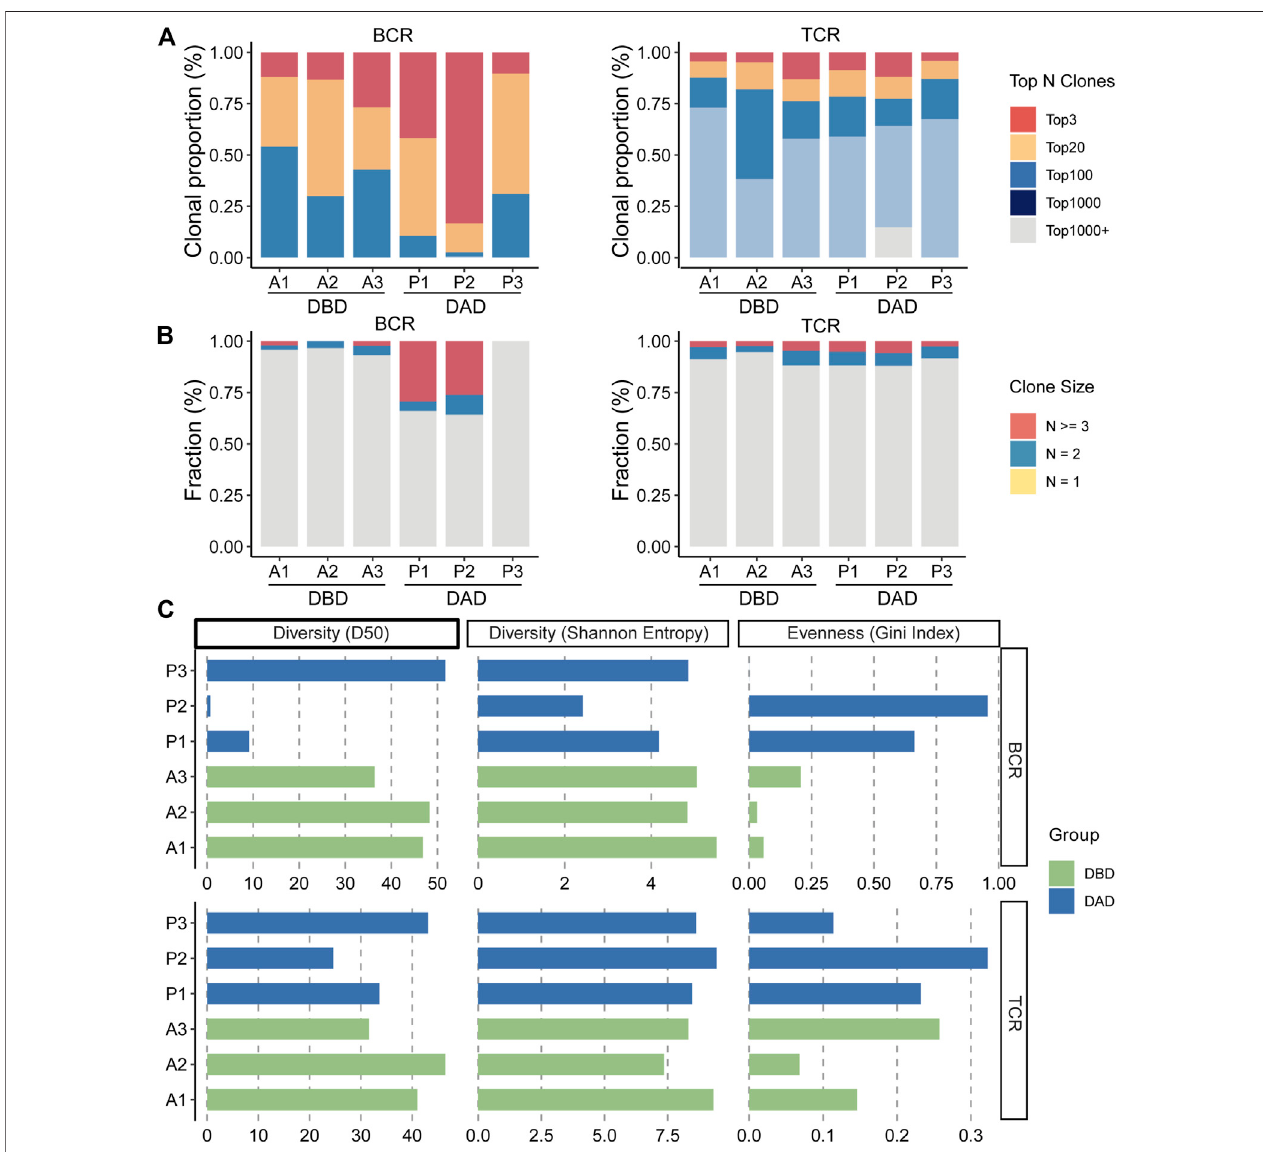
FIGURE5| CharacterizationofBCR/TCRrepertoiresinsixdeciduasamples. (A) ProportionofthetopNmostfrequentlyoccurringclones. (B) Proportionofunique and non-unique BCR/TCR clones. (C) D50, Shannon entropy, and Gini-coef fi cient scores of the BCR/TCR clones in six samples.